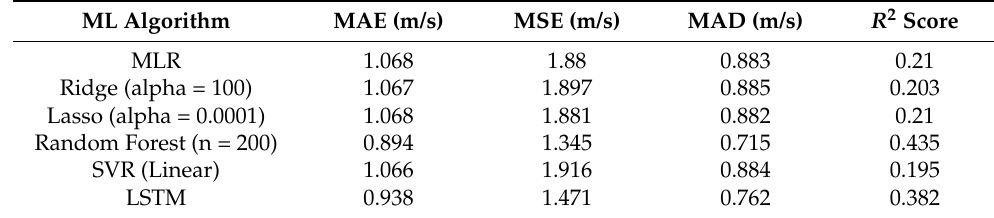
Table 4. Statistical error measures for machine-learning algorithms of the test